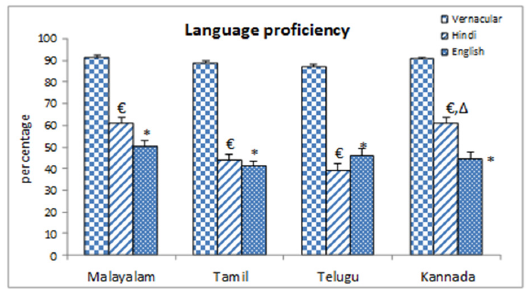
Figure-2: Self reported language proficiency level. * = Significant changes Vernacular vs. English (p˂0.05), € = Significant changes Vernacular vs. Hindi (p˂0.05), ∆ = Significant changes English vs. Hindi (p˂0.05).